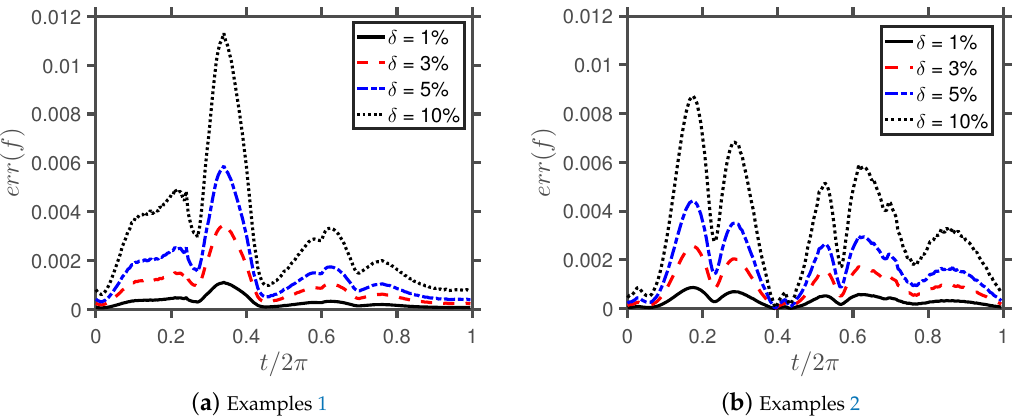
Figure 3. The relative errors of f obtained with various amounts of noise added in the boundary data on ∂ D .